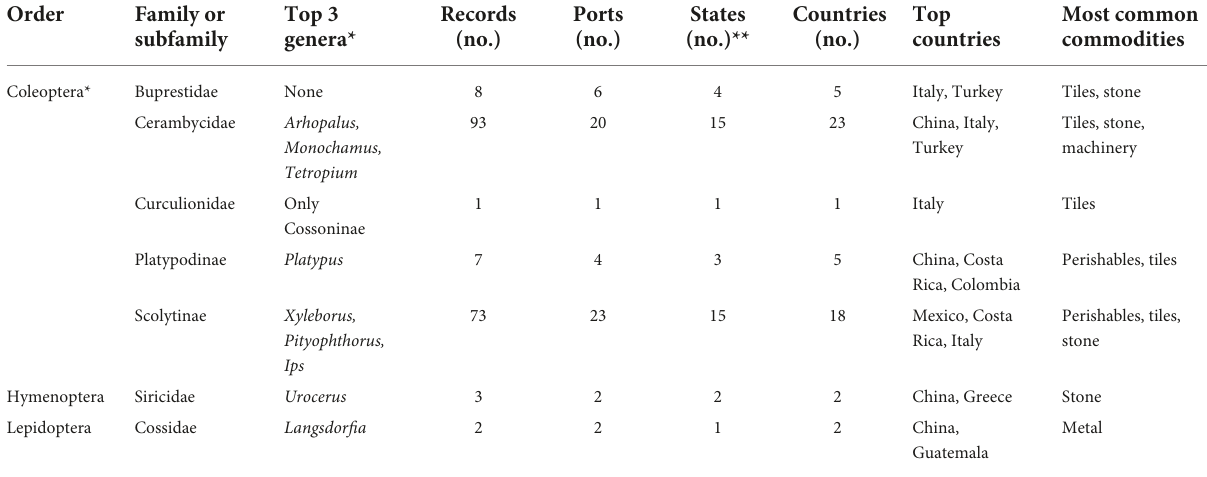
TABLE 2 Summary data for the wood borers reported in WPM in the AQIM program 2003–2020 by insect family or subfamily, based on the final dataset. Order